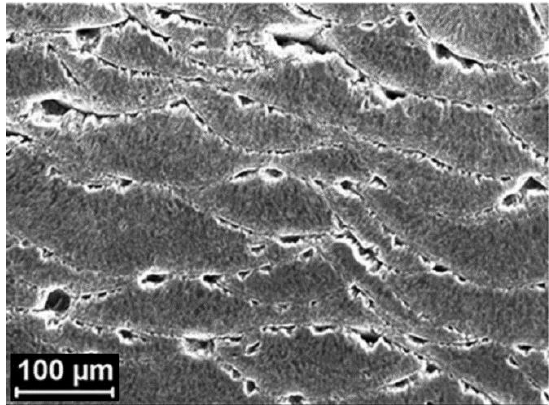
Figure 4. Secondary electron microscopy image of the surface of an as-built AM Al-Si (AlSi10Mg) corroded in NaCl solution. (Adapted from reference [47]).